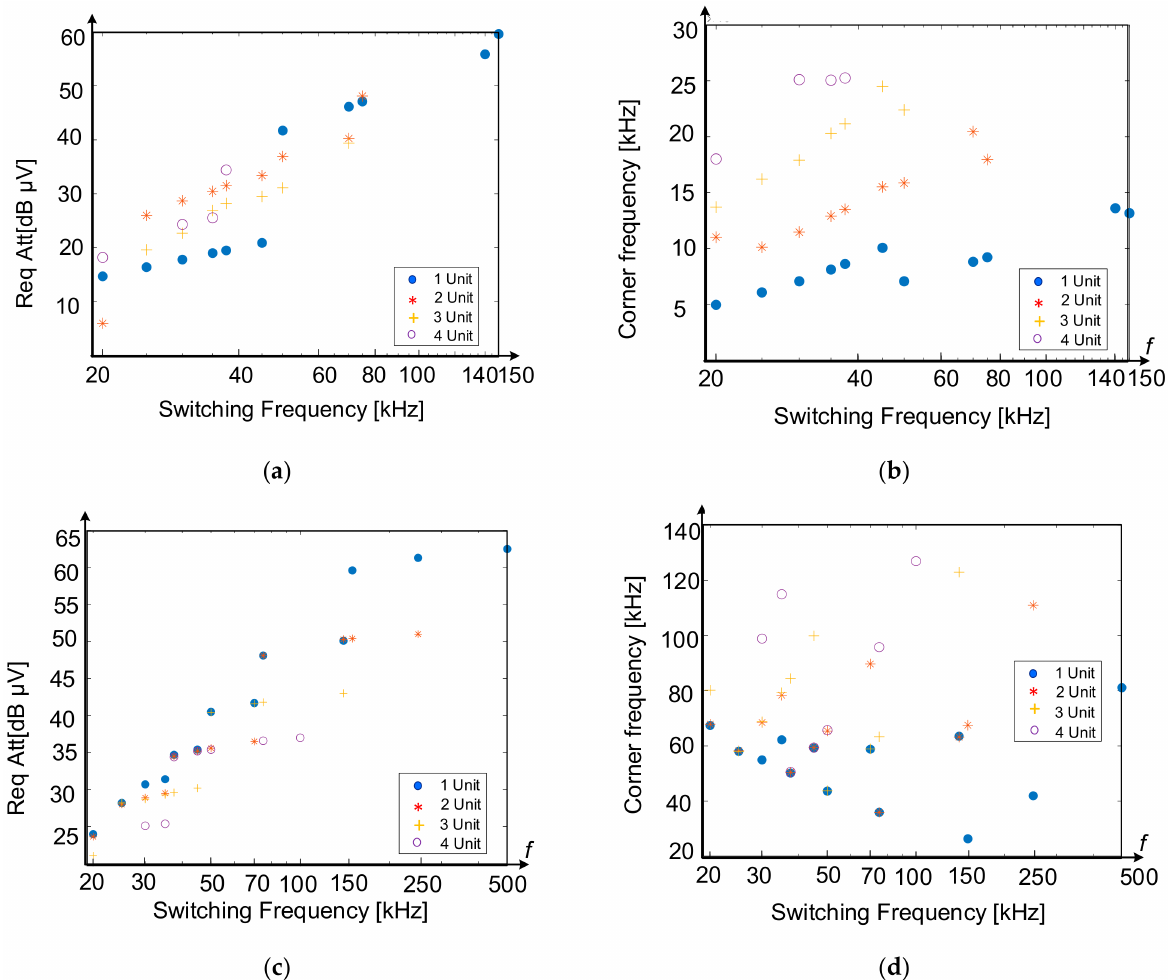
Figure 5. Relationship between attenuation requirement and the switching frequency (up to four units interleaved) in ( a ) Band A. ( c ) Band-B. The relationship between a two-stage filter corner frequency and switching frequency (up to four units interleaved) in ( b ) Band A ( d ) Band B for CCM based on the attenuation requirement (1)–(2). The conventional phase shift is considered 360 ◦ /N.